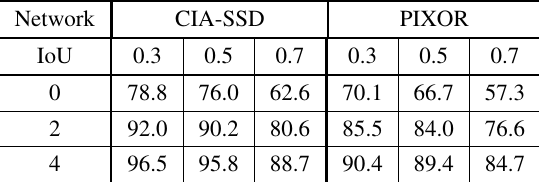
Table 1. Vehicles detection mAP of communication range 60m (in %). The second row defines the IoU threshold for calculating mAP. Number 0, 2, 4 in the first column indicates the number of cooperative vehicles.